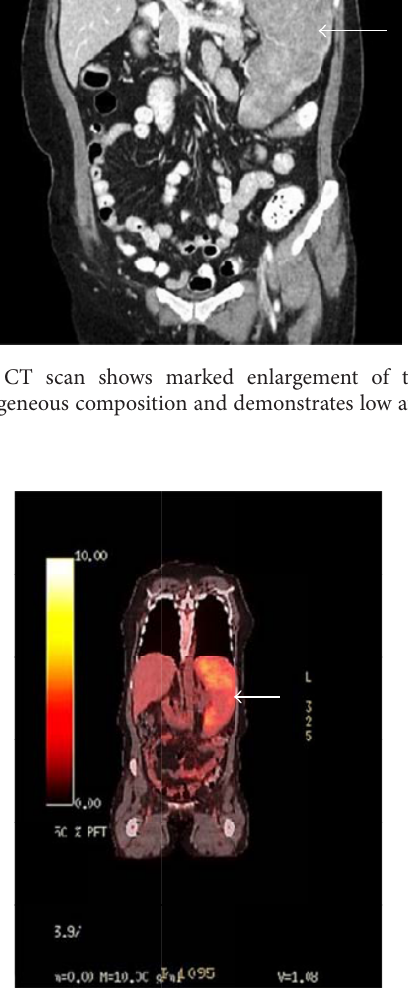
Figure 2: PET scan demonstrating an enlarged spleen with hyper-